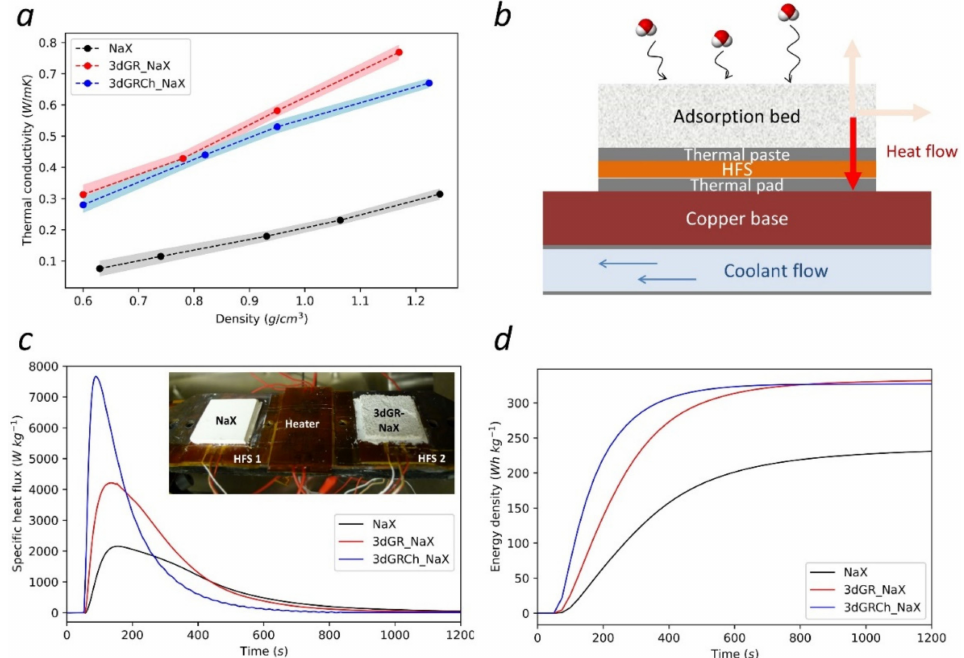
Figure 3. ( a ) Thermal conductivity comparisons of NaX (black), 3dGR-NaX (red) and 3dGRCh-NaX (blue). ( b ) A schematic side view of the heat-flux sensing adsorption platform (HFS) to measure specific heat flux responses and gravimetric energy density of the adsorption heat. ( c ) Specific heat flux responses and ( d ) gravimetric energy density adsorption stacks with 3dGRCh (blue triangle) and 3dGR (red rounds), and without binder (black square). The inset of ( c ). shows an image of experimental set up. The 3dGRCh-NaX composite exhibits increased thermal power density as its higher thermal conductivity increases the proportion of heat that is delivered to the substrate, rather than lost to the vapor ambient. The inset is an image of the experimental